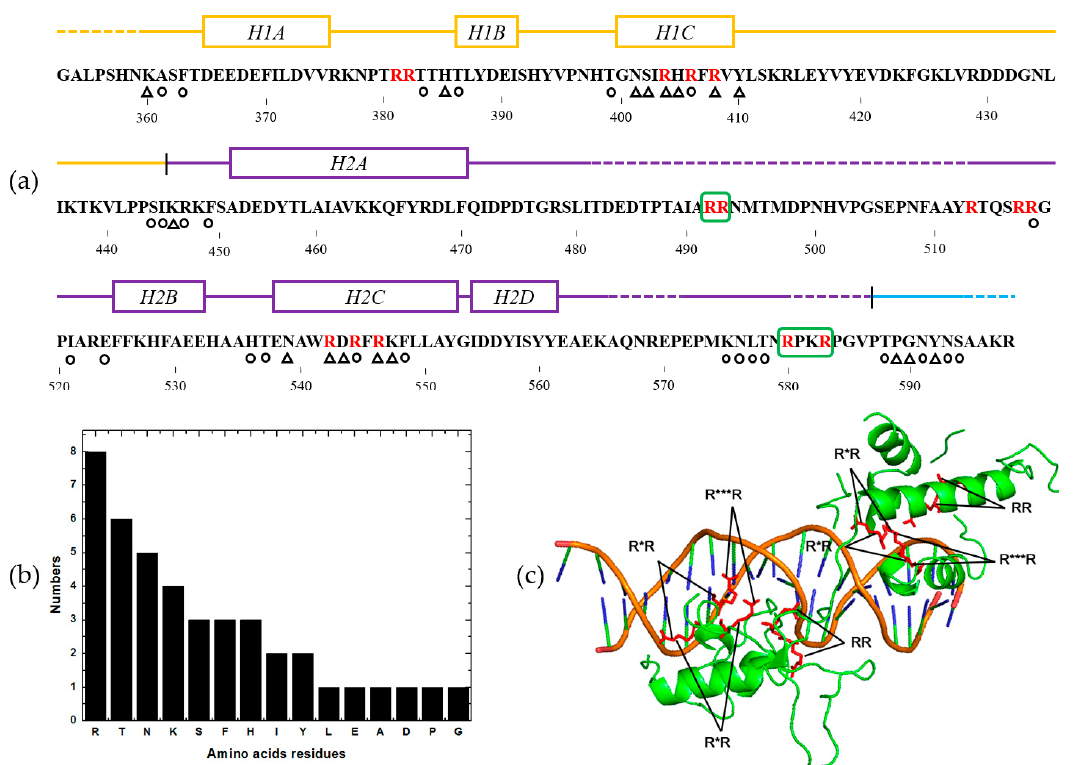
Figure 5. ( a ) The distributions of bigrams (R, R) in protein 1IGNB. The structural domains of this protein are color coded (orange represents domain 1, purple represents domain 2, and C-terminal tail is shown in blue). The open rectangles indicate the positions of helices, and broken lines mark regions of structural disorder. Residues interacting with DNA bases are indicated by triangles, and those contacting the phosphate backbone are indicated by circles. The two (R, R) bigrams shown in green rectangles are the two bigrams occurring in non-DNA-binding regions. ( b ) Histogram of the number of amino acid residues which binding with DNA in protein 1IGNB. ( c ) The distributions of bigrams (R, R) with different distances in the 3D structure of protein 1IGNB. The 3D structures of protein and DNA are shown in green and brown, respectively.